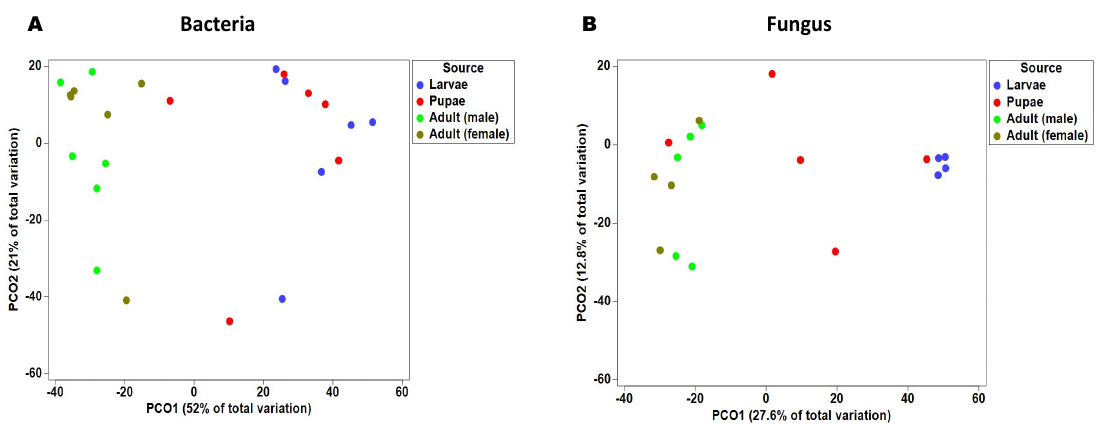
Figure 3. Principal co-ordinate analysis of the Qfly in the di ff erent developmental stages: ( A ) bacterial communities; ( B ) fungal communities. Di ff erent colors indicate the microbial communities in the di ff erent life stages of the Qfly.